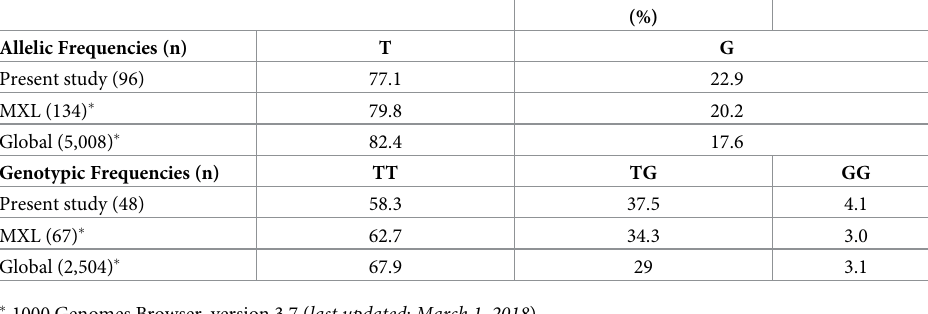
� 1000 Genomes Browser, version 3.7 ( last updated : March 1 , 2018 ) MXL = Mexican-ancestry in Los Angeles,